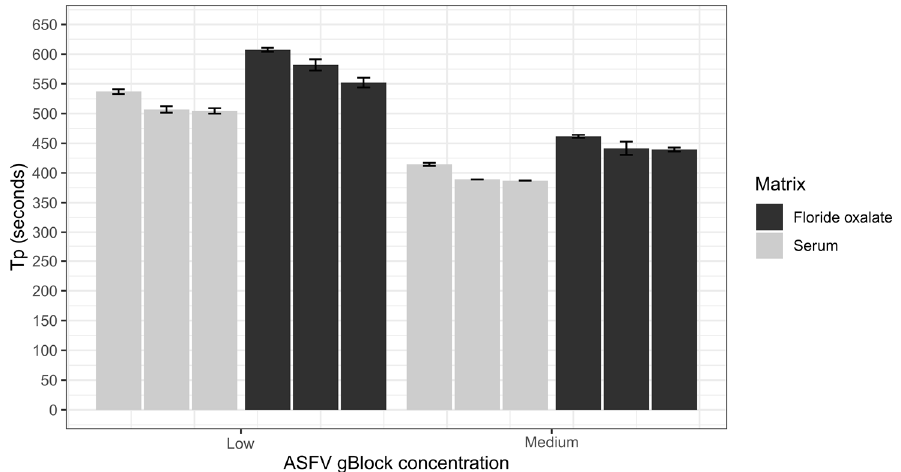
Figure 2. Repeatability of the ASFV LAMP assay was assessed by spiking a low (400 copies / rxn) and medium (40,000 copies / rxn) concentration of the ASFV gBlock into two sample matrices, serum and whole blood collected in fluoride oxalate tubes. All samples were tested in triplicates with error bars representing standard deviation. Table 3. Assessment of intra-assay variation of ASFV LAMP and coefficient of variation.